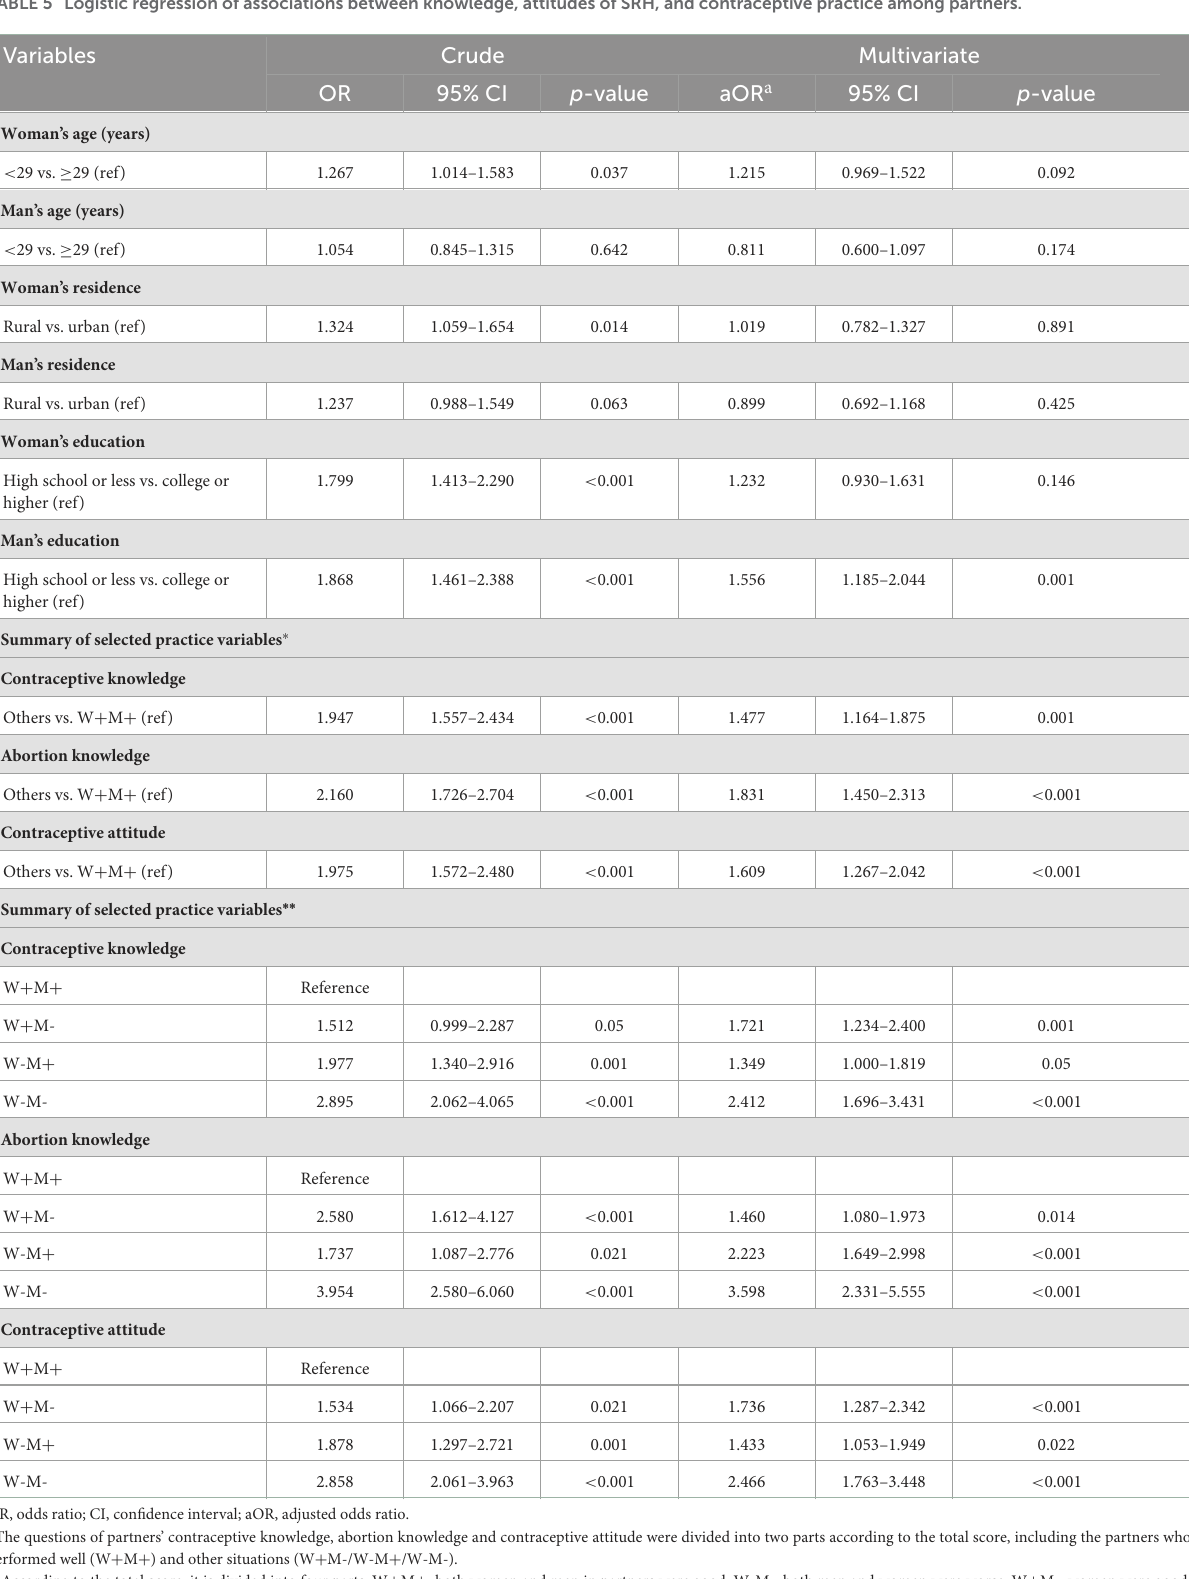
TABLE 5 Logistic regression of associations between knowledge, attitudes of SRH, and contraceptive practice among partners.